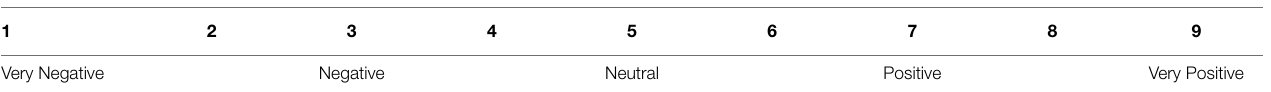
TABLE 2 | The emotional state after emotion arousal.